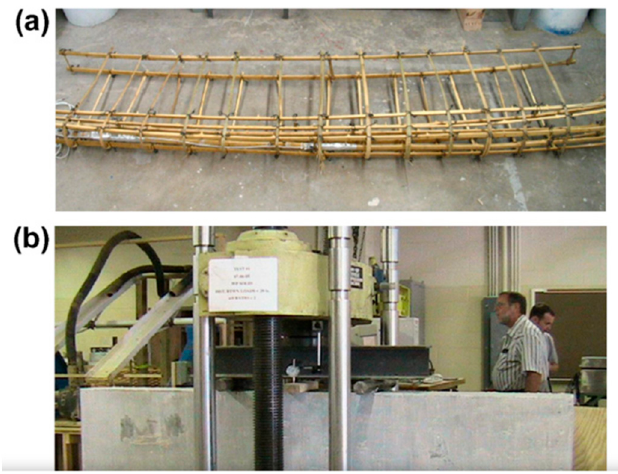
Figure 11. Concrete beams reinforced with bamboo rebars: ( a ) finished reinforcement, ( b ) the setup [51].